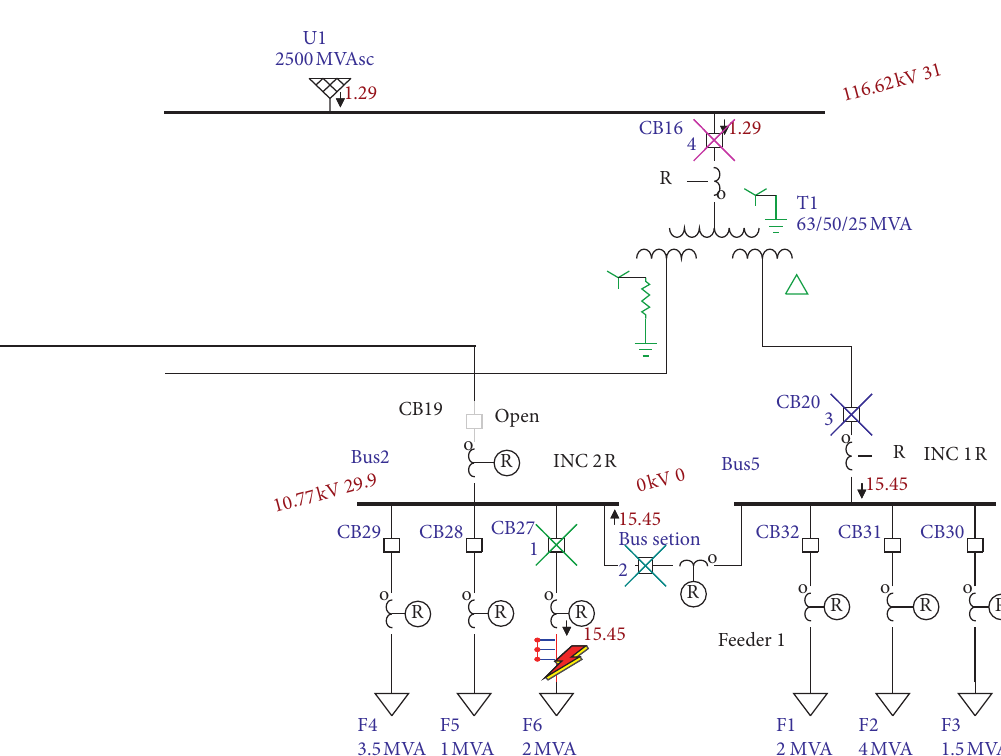
Figure 12: Relays operation sequence for feeder 6 fault with bus section CB,